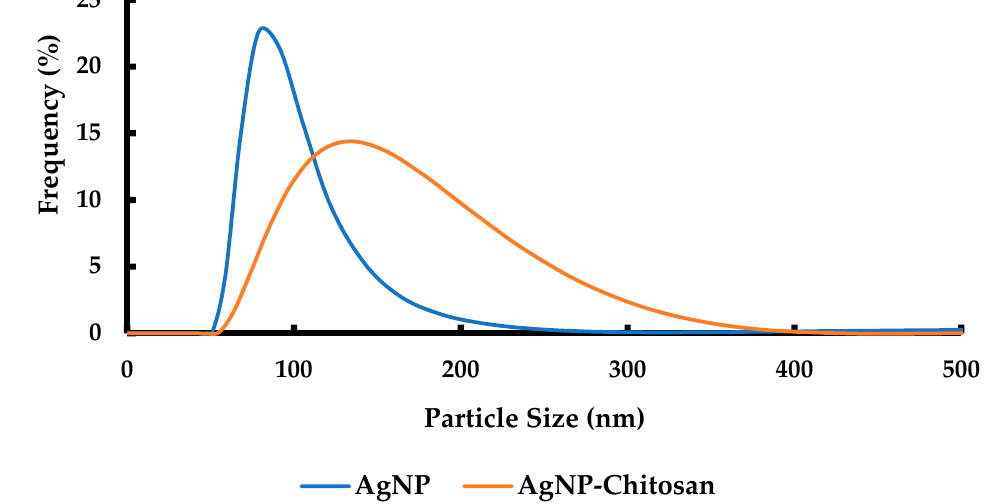
Figure 8. Particle size distribution of dynamic light scattering (DLS) for silver nanoparticles (AgNP) and silver nanoparticles coated by chitosan (AgNP-chitosan).